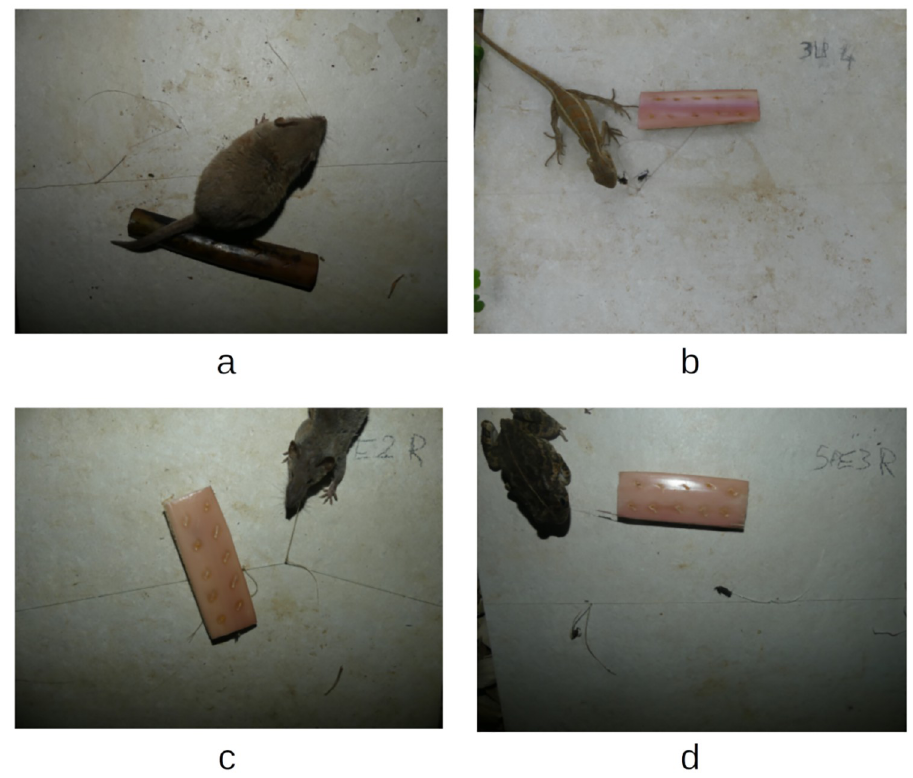
Fig 3. Images featuring the following predators of C . sordidus : a) Mus musculus ; b) Calotes versicolor ; c) Suncus murinus ; and d) Sclerophrys gutturalis .